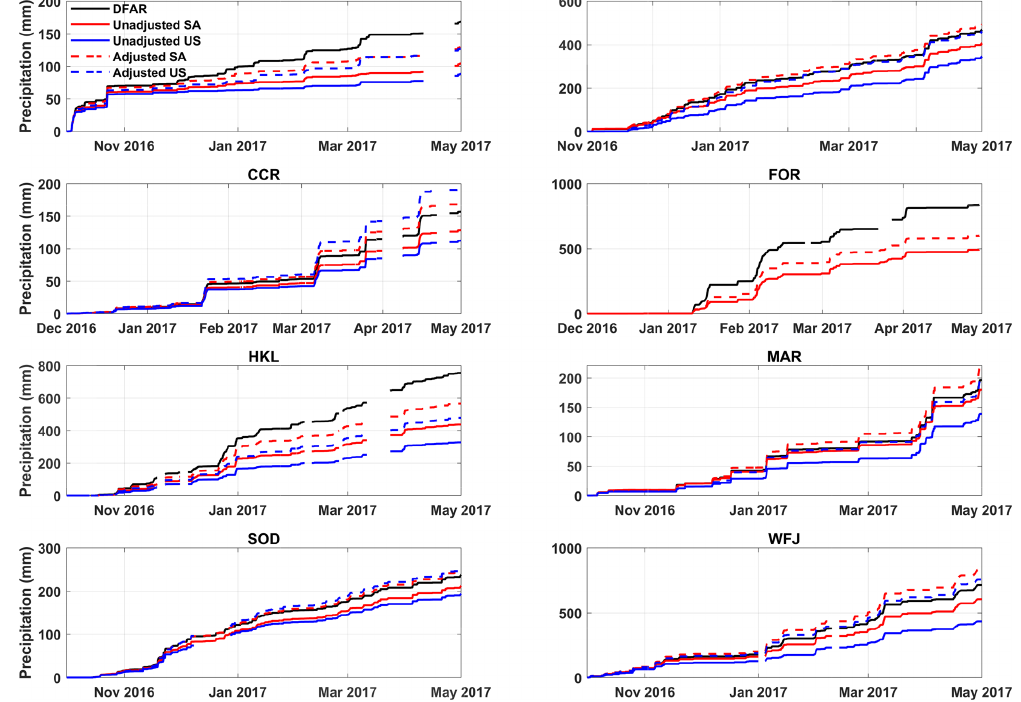
Figure 4. Time series of unadjusted (solid) and adjusted (dashed) precipitation time series for single Alter-shielded (red) and unshielded (blue) gauges as compared to the DFAR (black) during the 2016/2017 winter season at the eight SPICE sites.